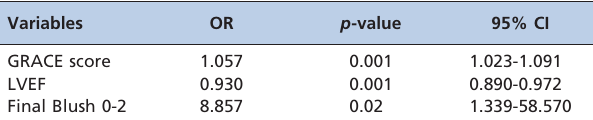
Table 2 - Independent predictors of mortality according to multivariate logistic regression